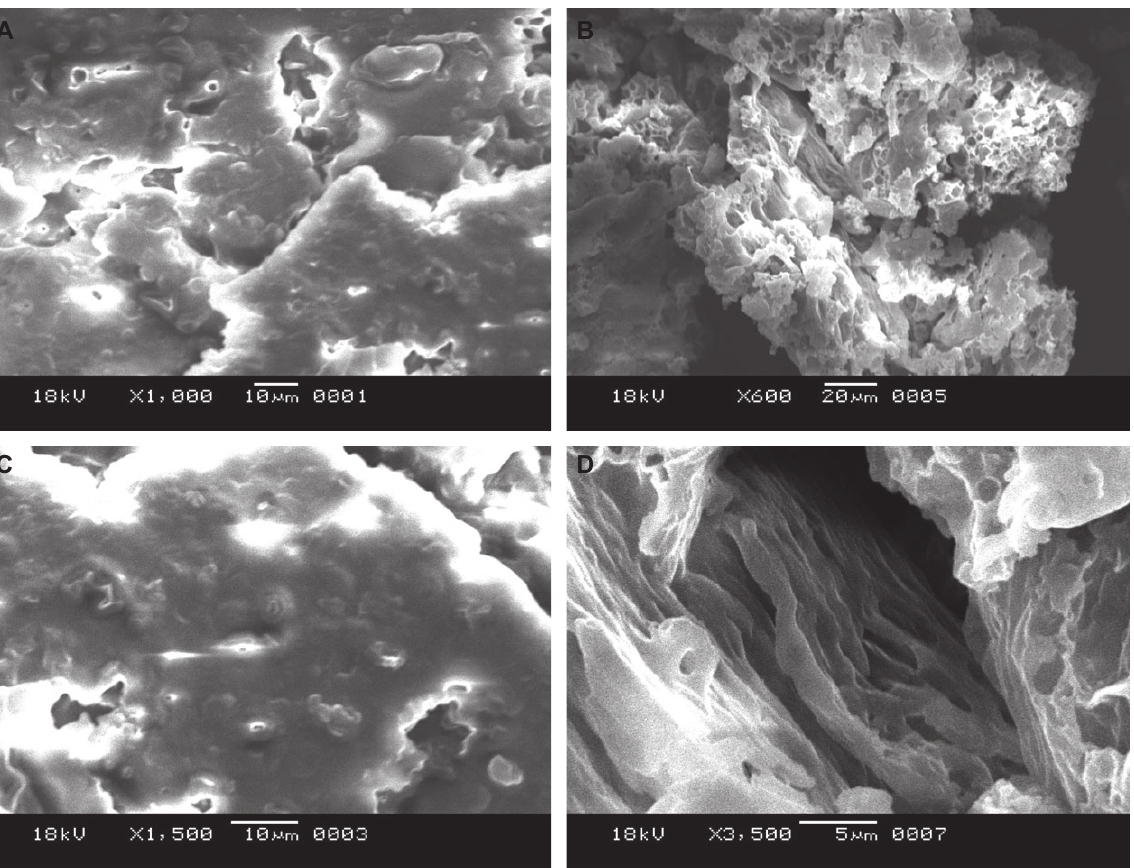
Figure 6 SEM of (A) surface before dissolution in pH 1.2, (B) surface after dissolution in pH 1.2, (C) surface before dissolution in pH 7.4 and (D) surface after dissolution in pH